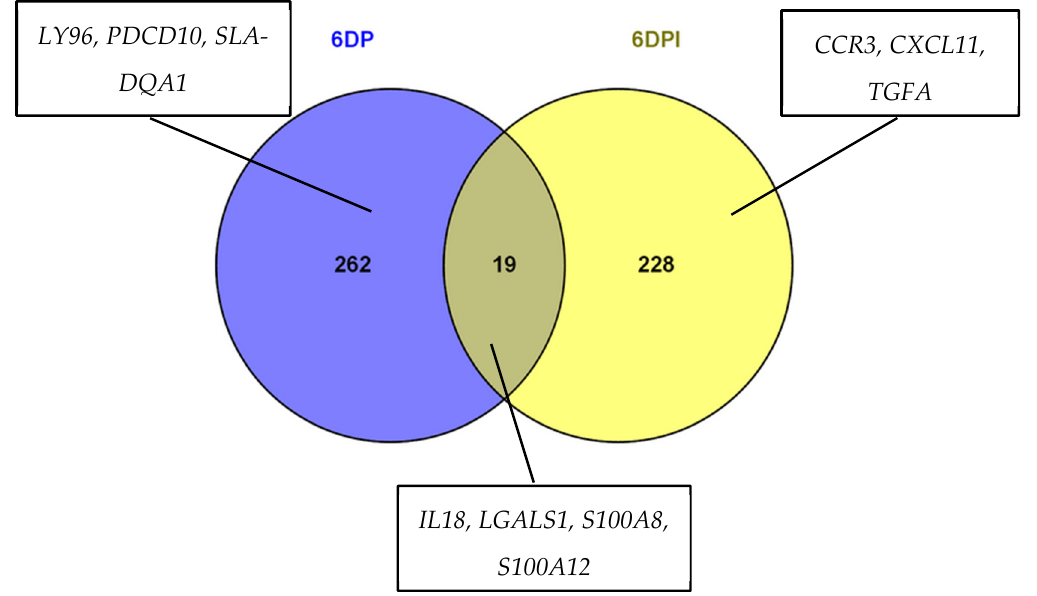
Figure 1. Venn diagram showing number of shared and unique DEGs altered on Day 6 of pregnancy (6DP) and Day 6 after SP infusion (6DPI) in comparison to 6 Day of estrous cycle. Genes chosen for qPCR validation are listed in boxes.